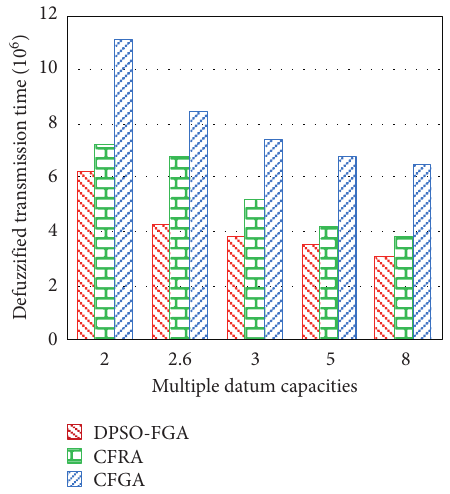
Figure 3: Average fuzzy data transmission time of different al- gorithms with various capacities of private data centers.